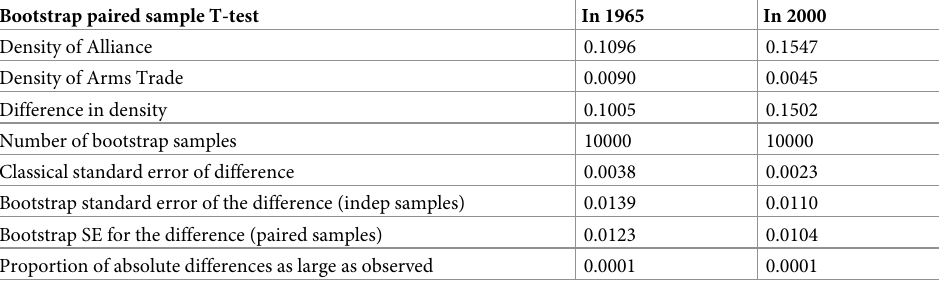
Table 1. Density comparison of the political alliance network and the arms trade network (in 1965 and in 2000).